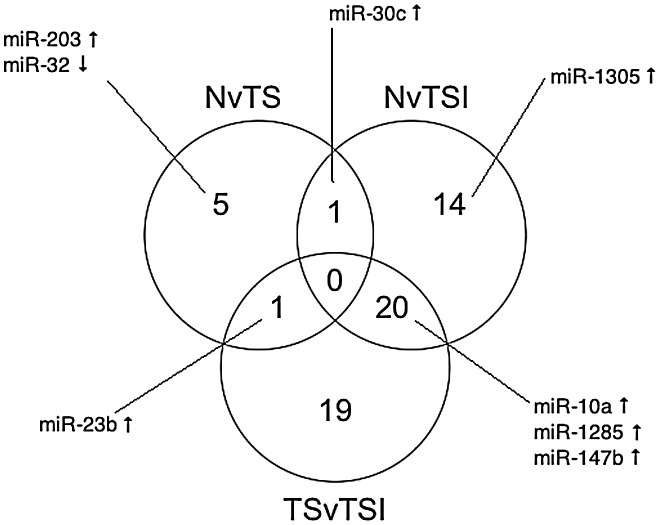
Venn diagram of differentially expressed miR.Venn diagram showing the number of differentially expressed (FC>3, p<0.05) miR that are unique or that overlap between the different clinical phenotypes. Selected miR of interest are shown with arrows illustrating whether they are up- or down-regulated in the indicated comparison group. An upward facing arrow indicates up-regulation and a downward facing arrow indicates down-regulation. * miR-23b is up-regulated in N v TS but down-regulated in the TS v TSI comparison group.